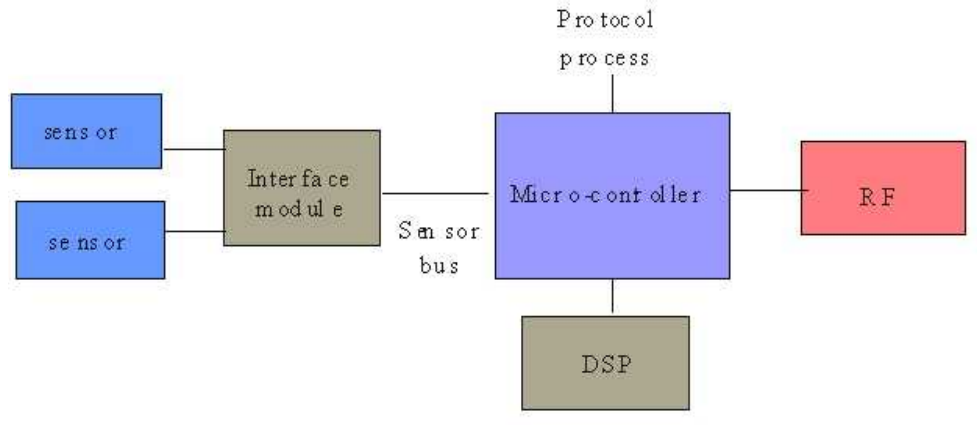
Figure 9 . Sensor node structure for wireless